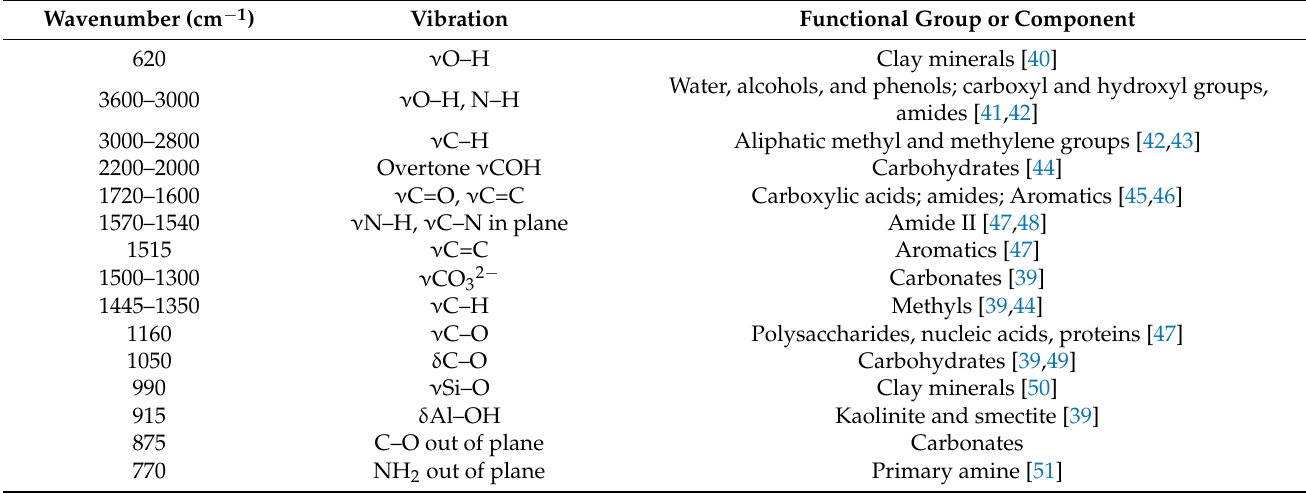
Table 3. Assignment of the characteristic bands in FTIR-ATR